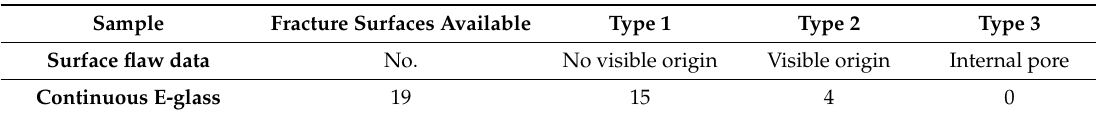
Table 2. Summary of flaws observed on fracture surfaces produced by failure in pure tension, using both as-received and heat treated E-glass fibres.